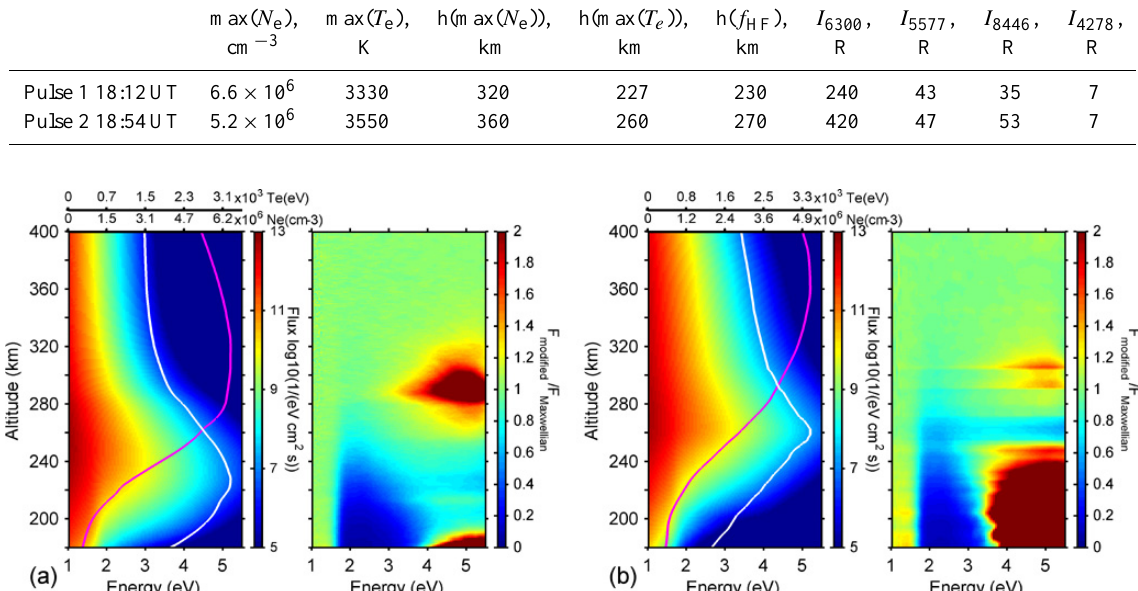
determined using the loss function derived by Swartz et